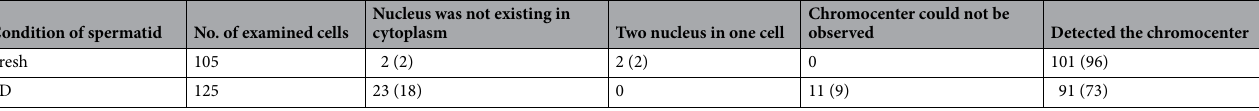
Table 1. Detection of the chromocenter of cells collected by morphological markers using Hoechst